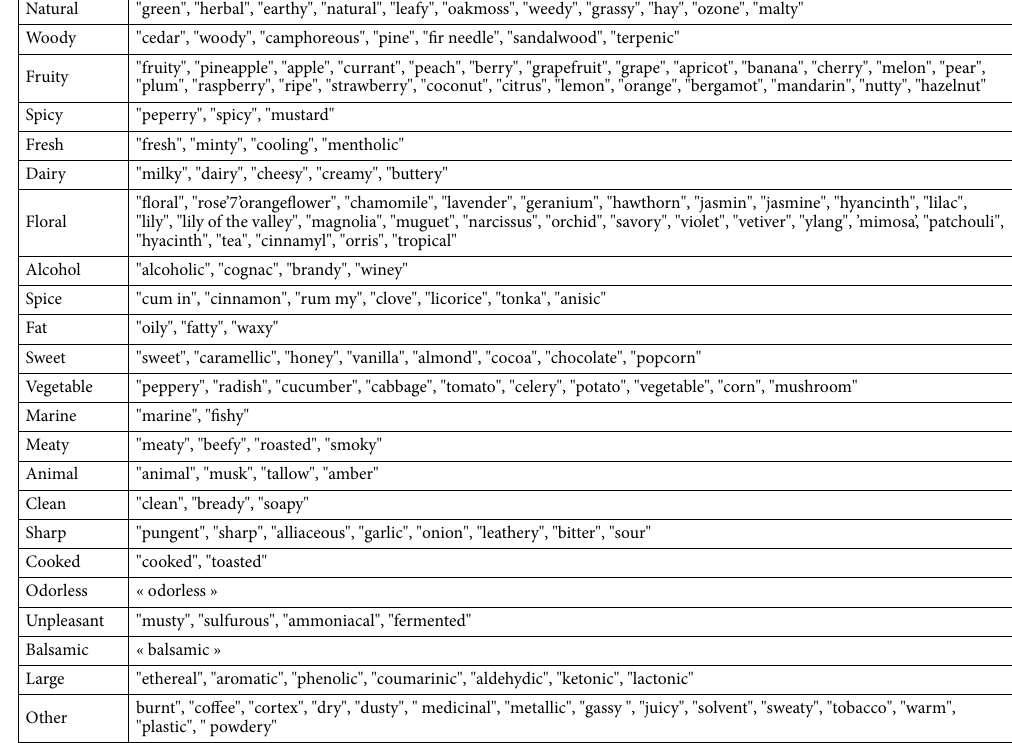
Table 2. Grouping of odor notes in categories having a similar perceptual space.